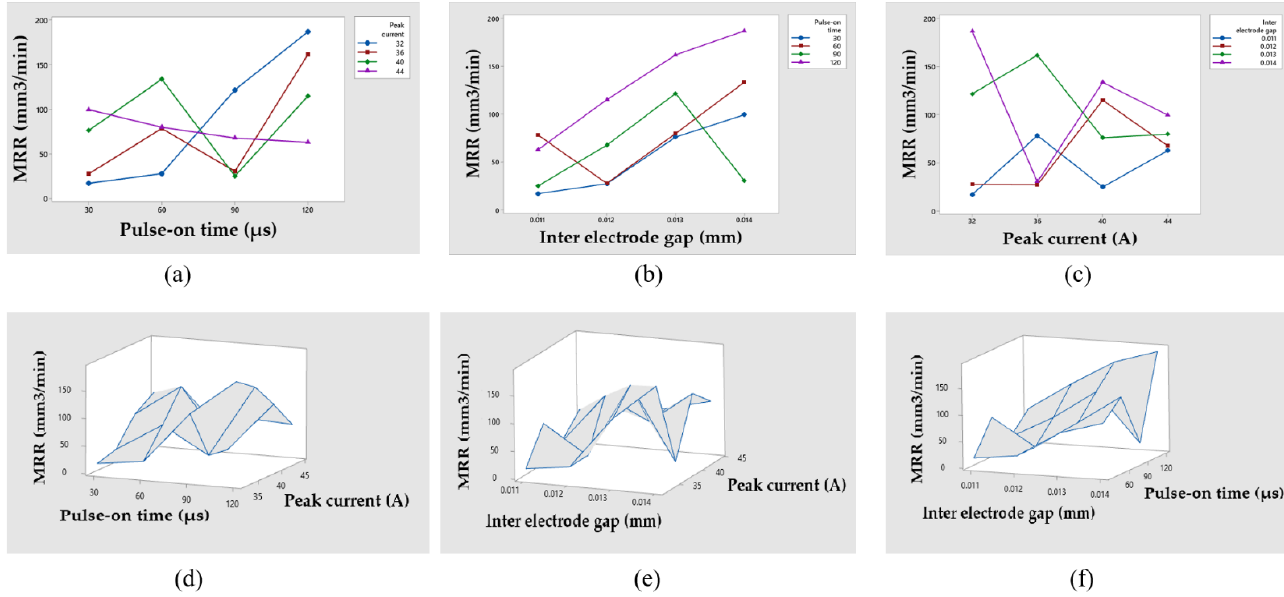
Figure 4. Influences of different EDM input variables on MRR with its surface plots. ( a ) Influence of T on on MRR. ( b ) Influence of IEG on MRR. ( c ) Influence of I on MRR. ( d ) MRR vs. I and T on . ( e ) MRR vs. I and IEG. ( f ) MRR vs. T on and IEG.